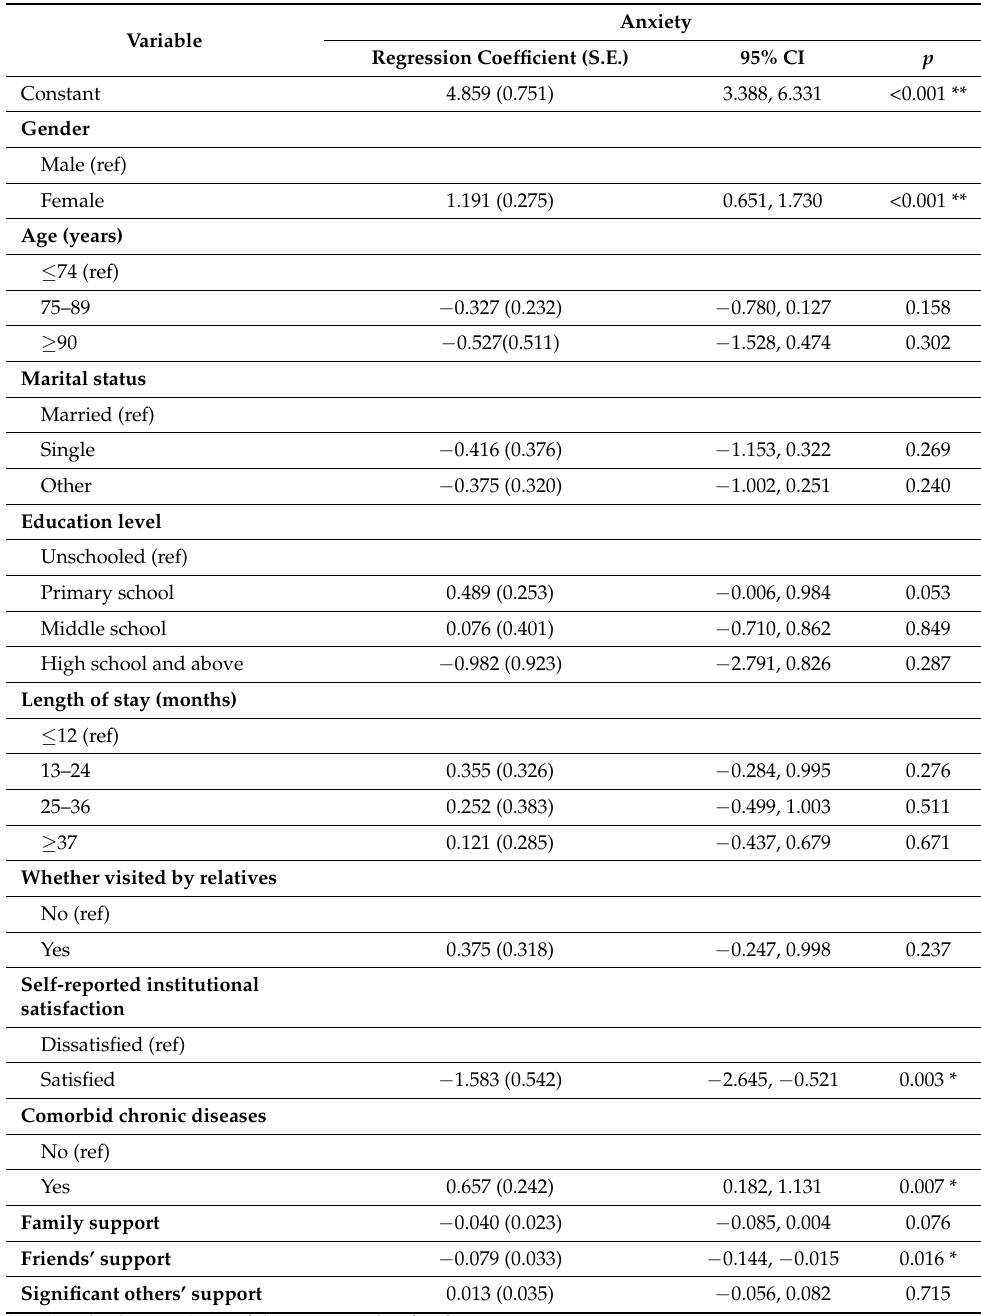
Table 4. Analysis results of the generalized linear model for the relationship between anxiety and three subscales of social support and sociodemographic variables among